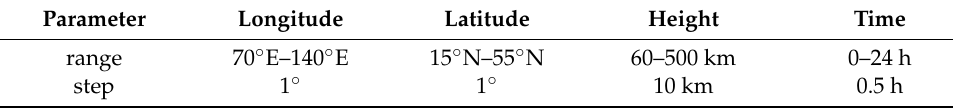
Table 2. Spatial and temporal division of electron